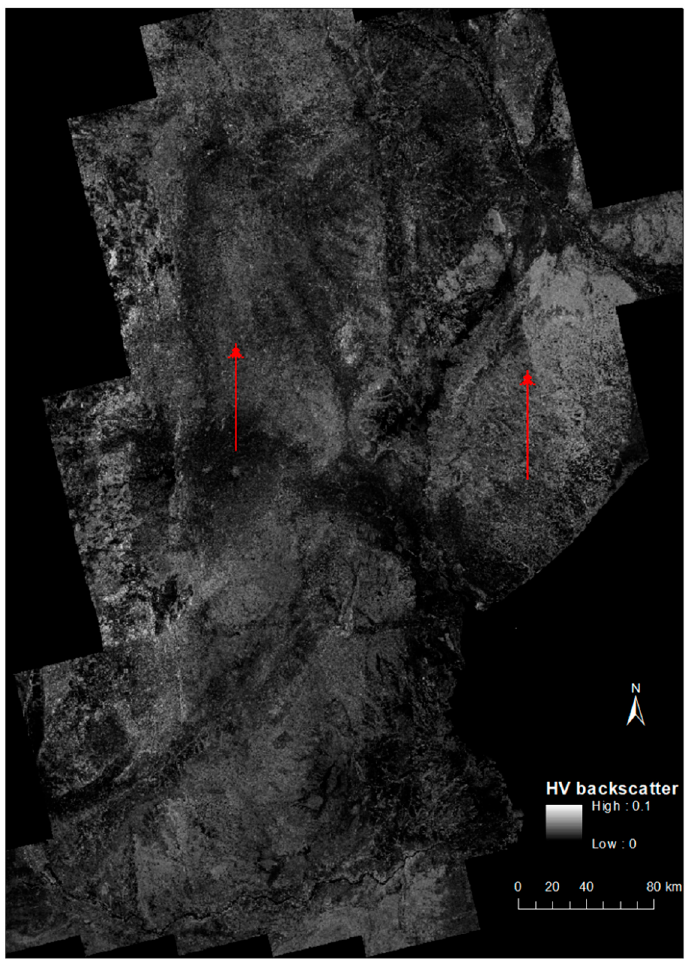
Figure A1. Backscatter mosaic from L-band ALOS PALSAR imagery at HV polarization for the study site in Manica and Sofala Provinces in central Mozambique in 2010. The red arrow points to the most obvious ‘banding’ effects between paths in this mosaic. Stripes for other adjacent paths are also evident but less extreme and only visible when zoomed in.